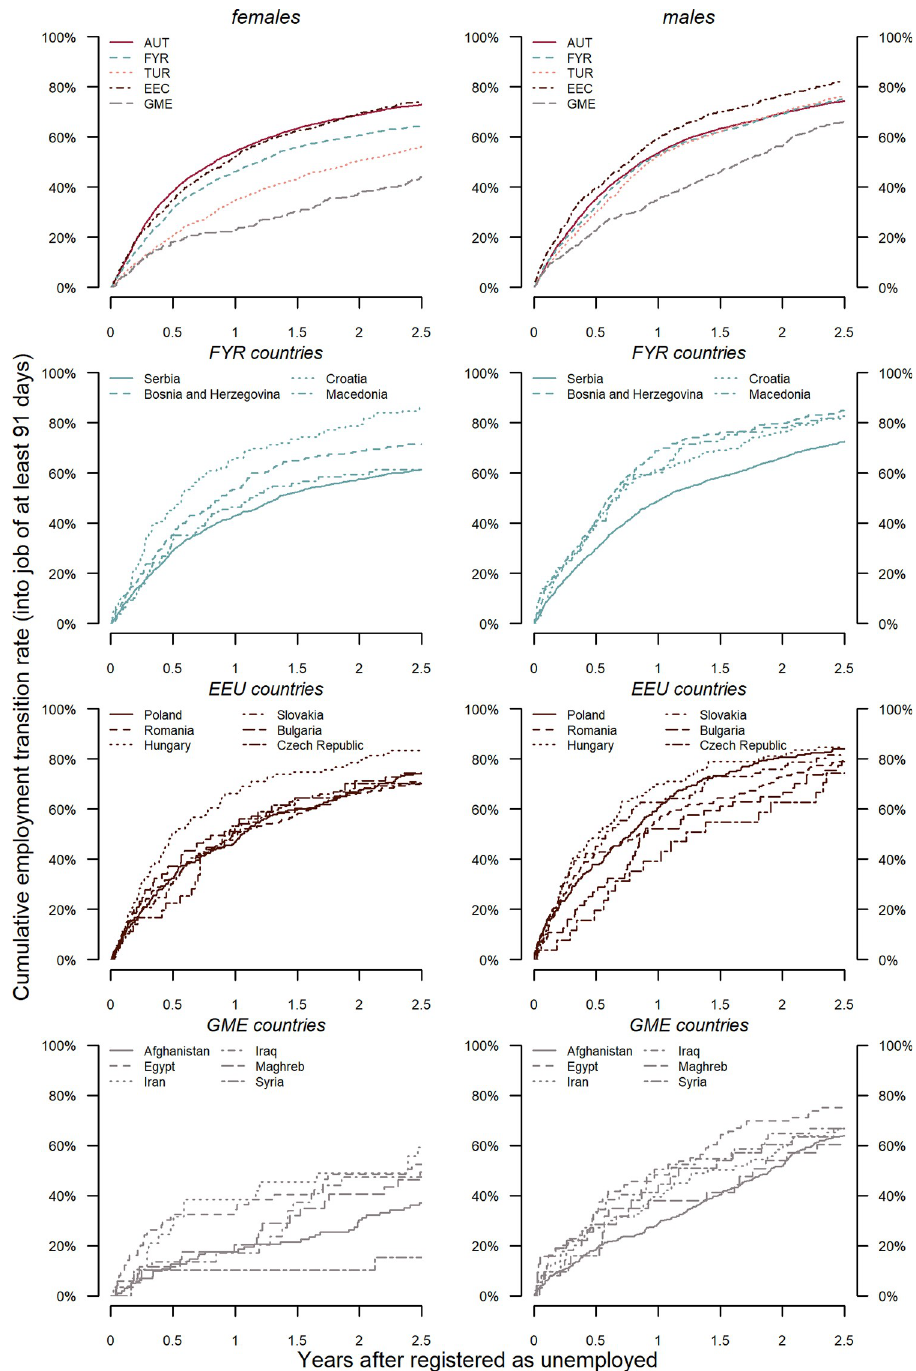
Fig 1. Cumulative transition rates into first employment spell of young adults within 2.5 years after registered as unemployed. Source LMDB. Among females, the upper row reveals a hierarchy with native Austrians and Eastern Euro- peans at the top, followed by Former Yugoslavs, Turks and immigrants from Middle East at the bottom. Within the country groups, there is considerable variation among former